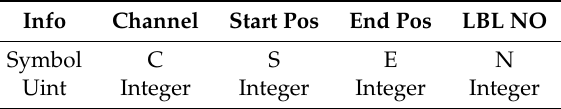
Table 2. Point cloud set node.